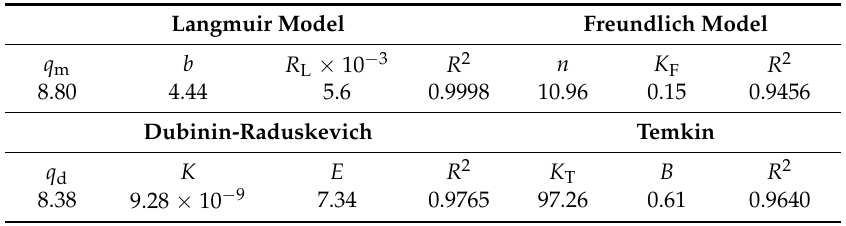
Table 6. Calculated isotherms parameters. Experimental conditions: CNF = 0.1 g, V = 100 mL of [Cu 2+ ] = variable pH = 4, T = 298 K, θ = 500